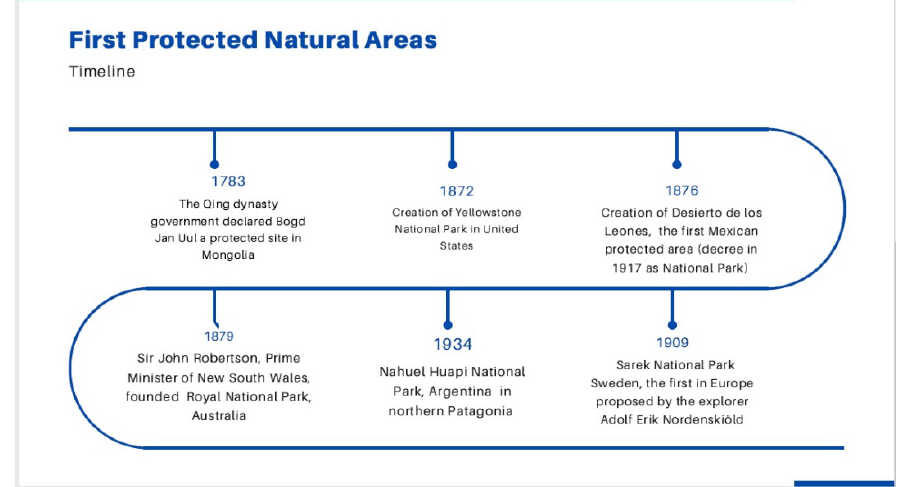
Figure 2. Timeline of some of the first Protected Natural Areas.